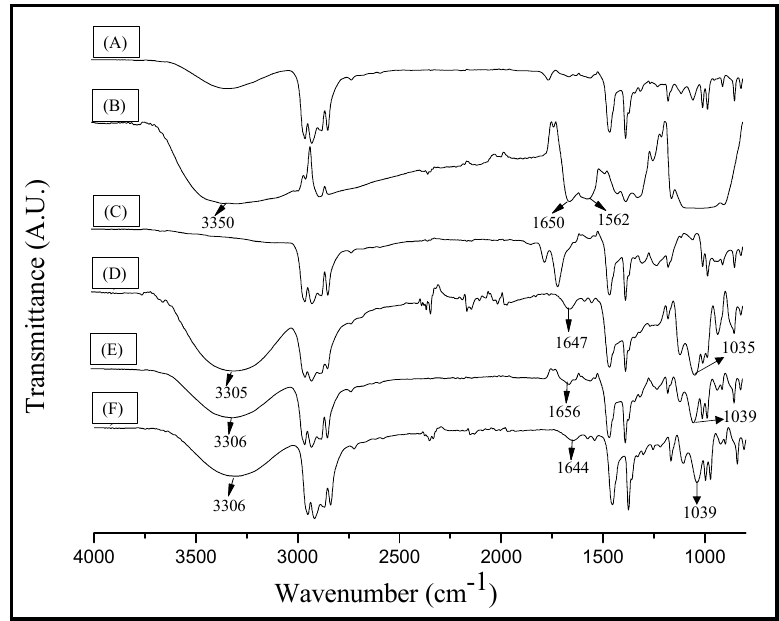
Figure 1. Infrared spectroscopy of ( A ) PP; ( B ) Chitosan; ( C ) PPgMA; ( D ) A9; ( E ) B9; ( F ) C9.